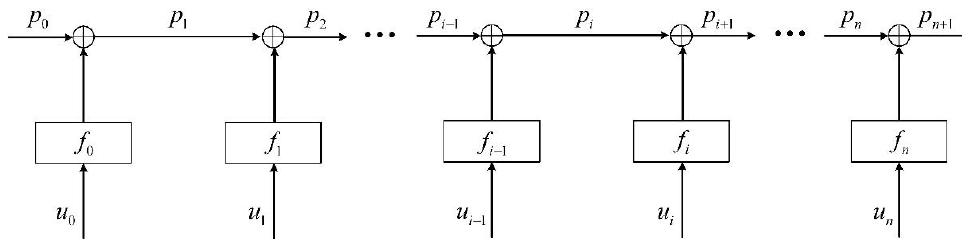
Figure 10. Recursion reconstruction model.